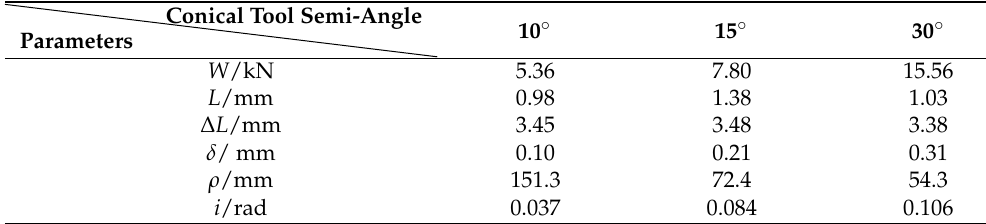
Table 2. Parameters for calculating yield stress.